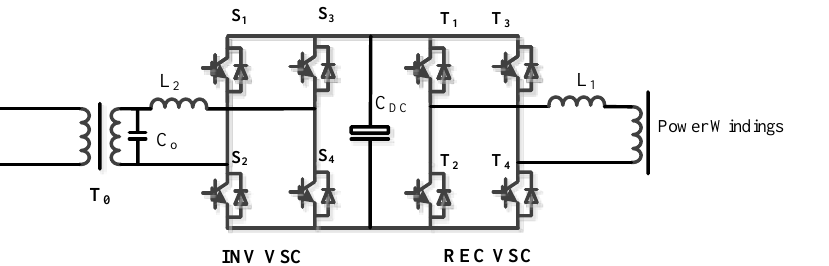
Figure 3. Schematic diagram of power electronic converter module.